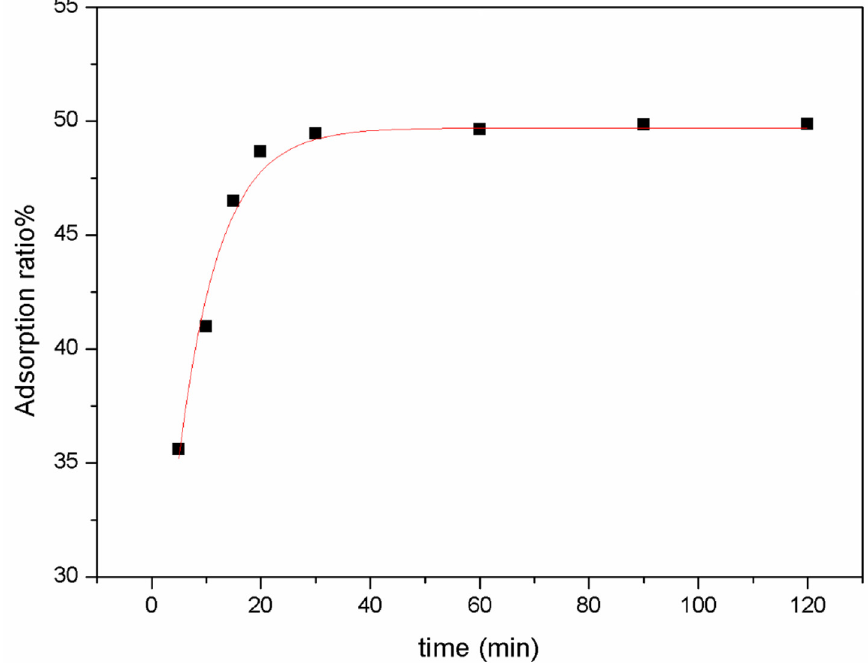
Figure 4. Effect of contact time (solid/liquid ratio = 0.032 g/L; C 0 [Th(IV)] = 19.00 ± 0.10 mg/L; pH = 3.00 ± 0.05; T = 298.15 ± 1.00 K). Table 2. Kinetic parameters for Th(IV) adsorbed onto